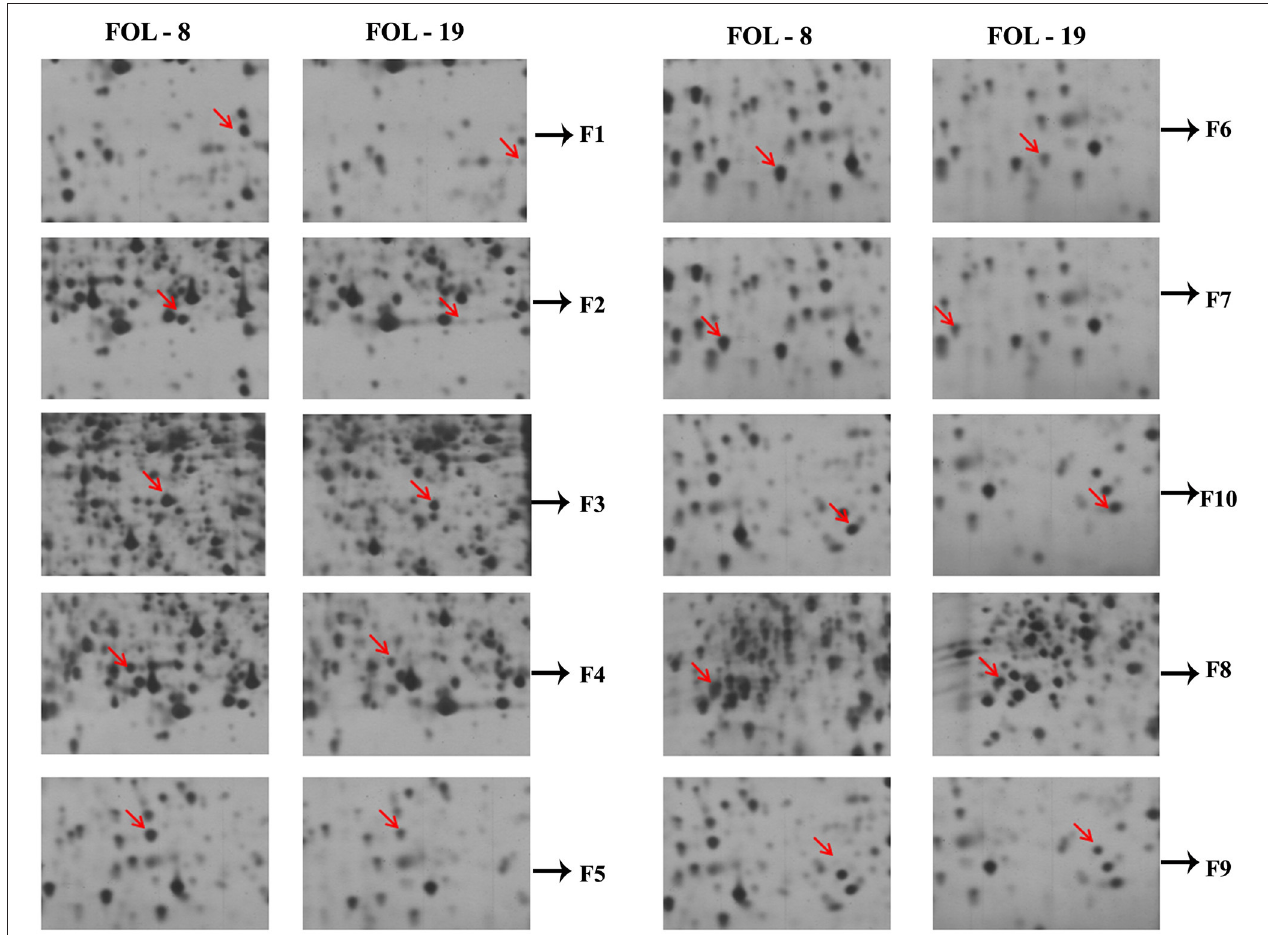
FIGURE 5 | Differential expression of virulent proteins in Fusarium oxysporum f.sp. lycopersici isolates causing wilt disease in tomato.